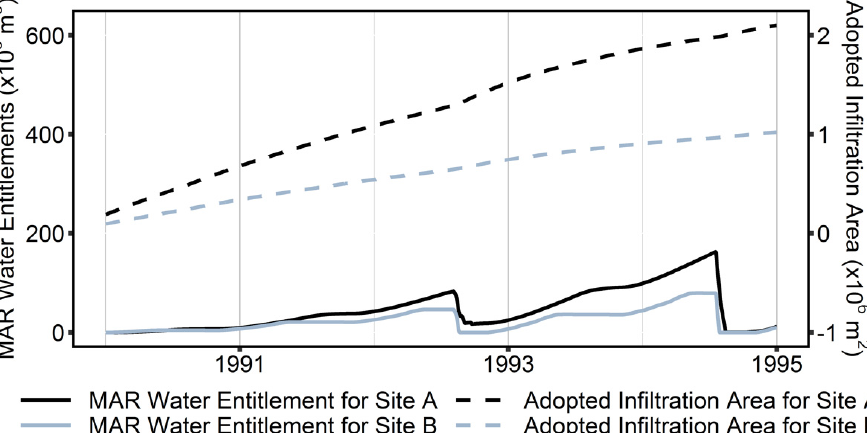
Figure 12. Cumulative MAR entitlements at Site A and Site B and adopted infiltration area during multi-year droughts from 1992 to 1994.